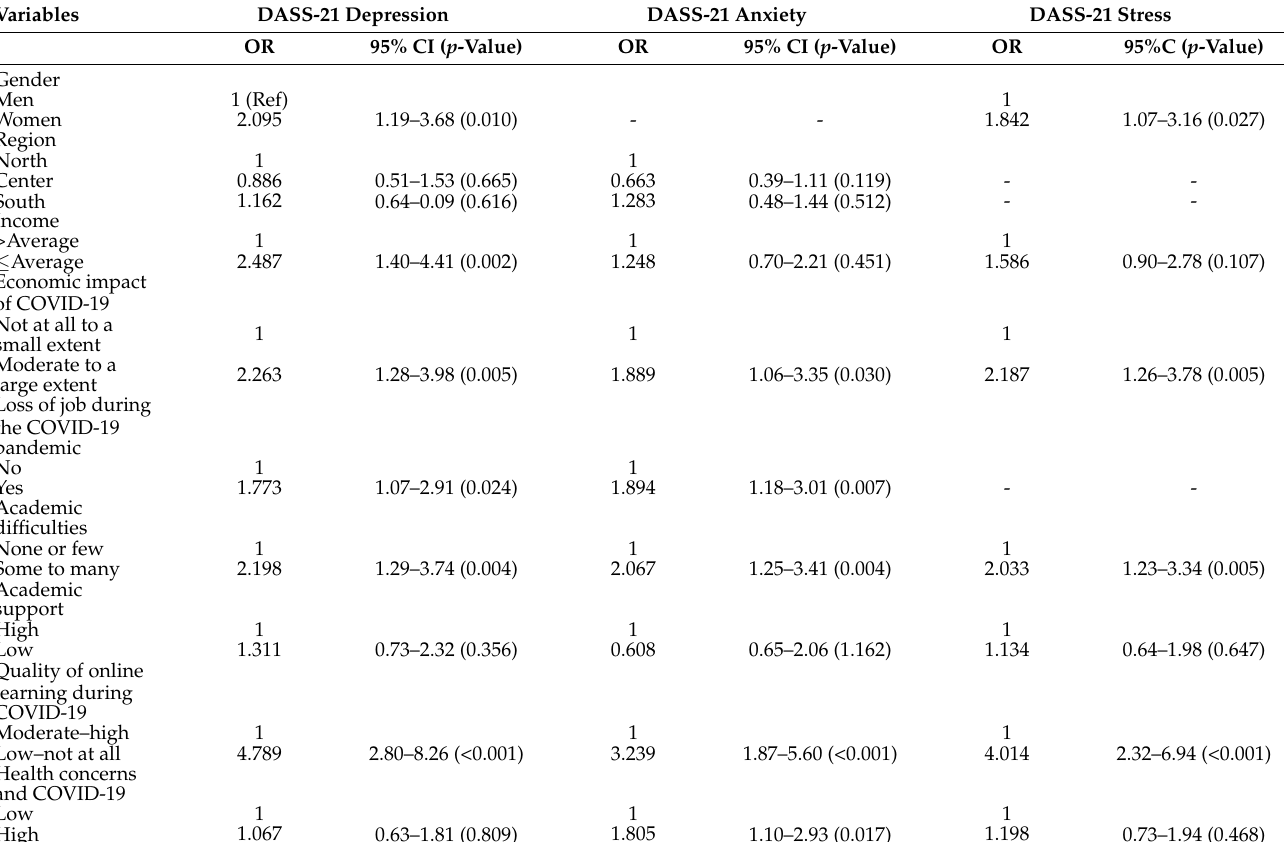
Table 3. Multiple logistic regression of demographic, academic and health factors, and mental health ( n =